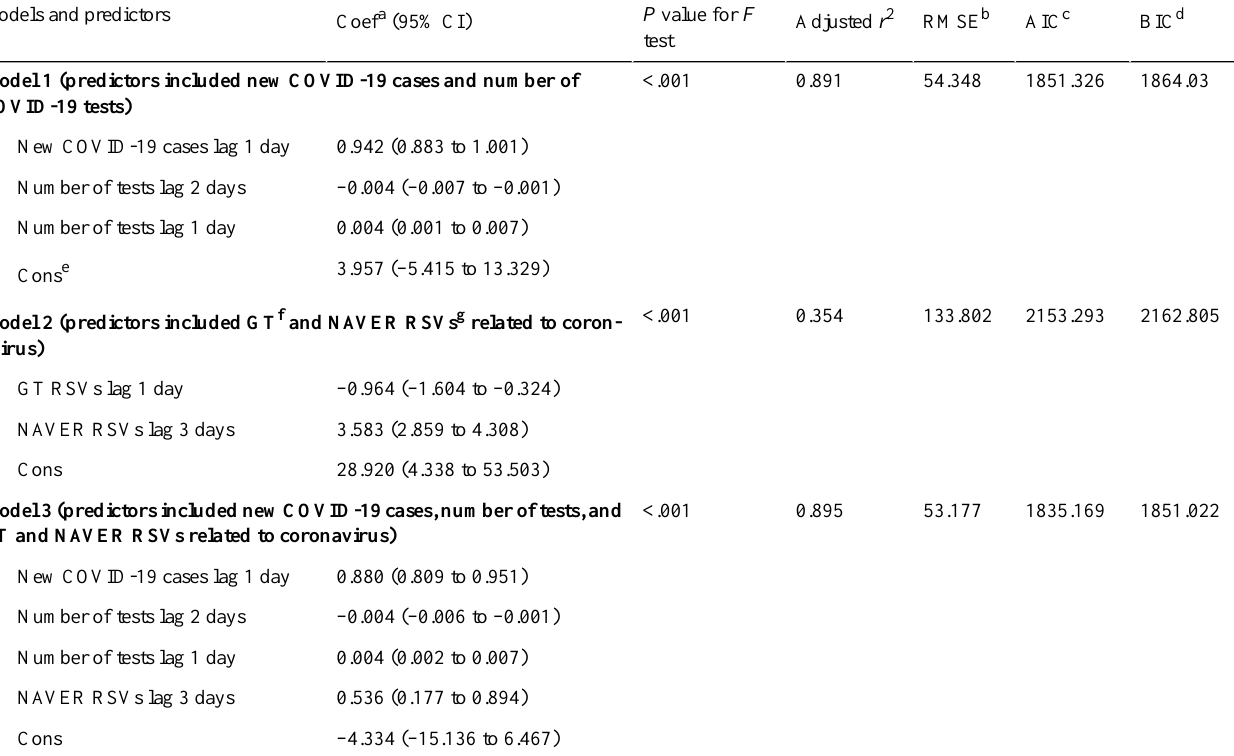
Table 4. Prediction model of new COVID-19 cases in South Korea.